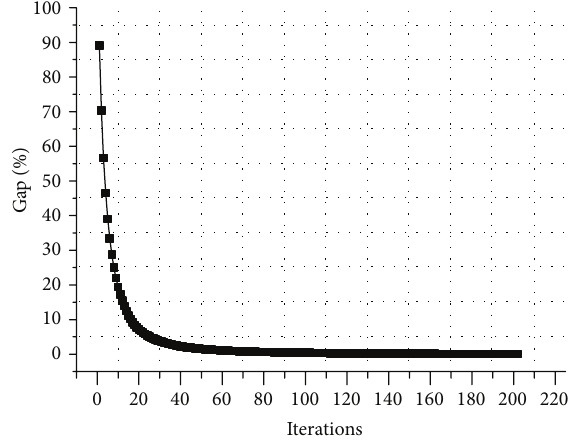
Figure 3: Convergence characteristics for 𝜃 = 1